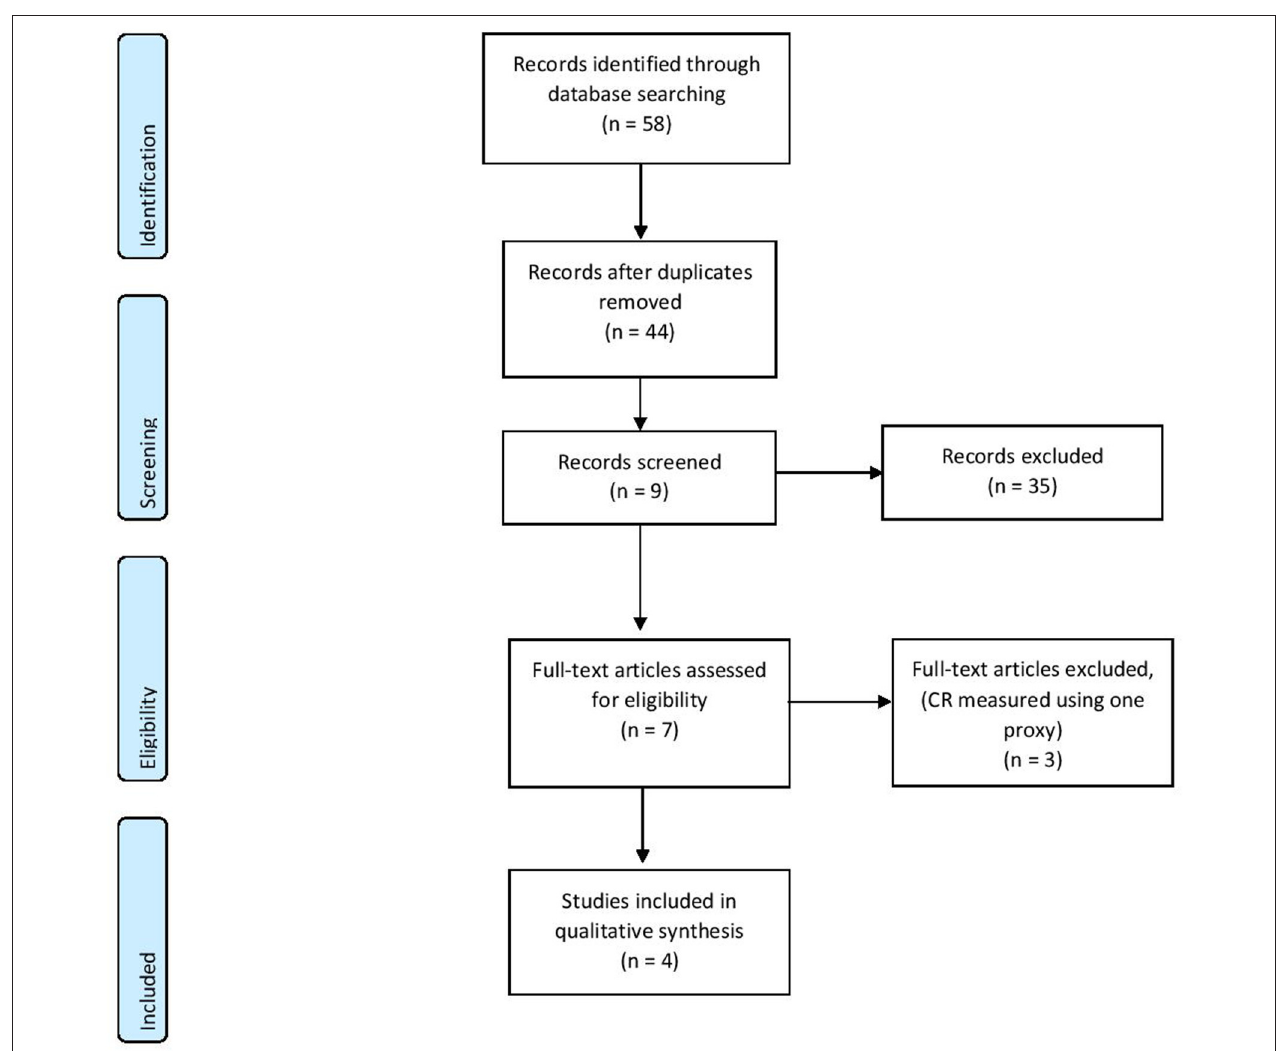
FIGURE 1 | PRISMA diagram of the reviewing process (Moher et al.,